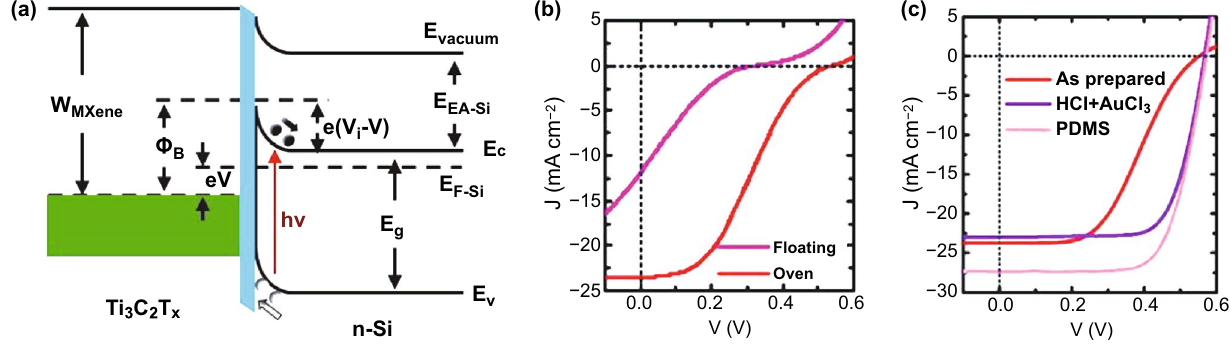
Fig. 10 Ti 3 C 2 T x MXene/ n -Si solar cells: a Energy-level alignment of the main components (the blue strip indicates the SiO 2 thin layer), b illu- minated J – V curves for the devices fabricated via floating and oven transfer methods and c illuminated J – V curves for the devices fabricated by the oven transfer method and after the two-step (HCl + AuCl 3 ) chemical treatment and further coating the PDMS antireflection film. Copyright © 2019 WILEY ‐ VCH Verlag GmbH & Co. KGaA,